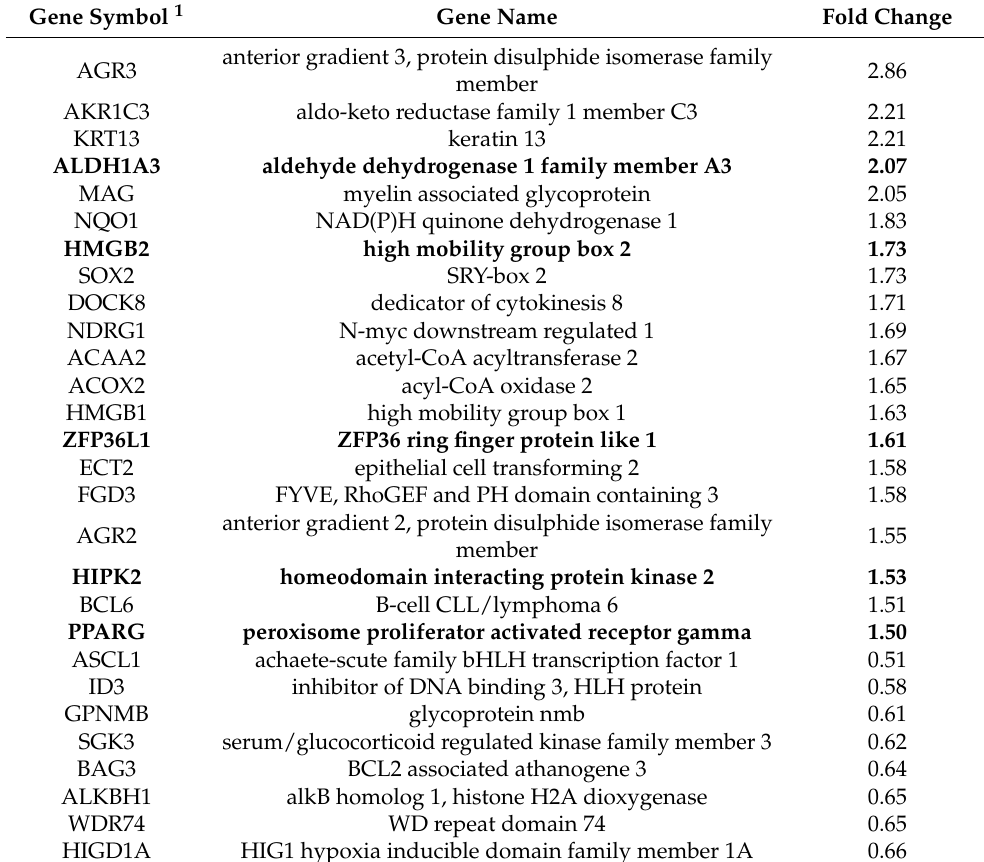
Table 4. List of cell-death-related genes differentially expressed only in MCF7-ER β 1 cells.